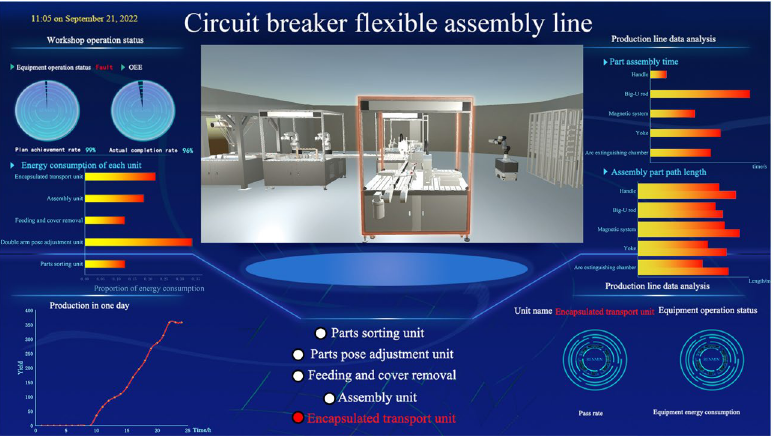
Figure 28. System display in the event of a fault.